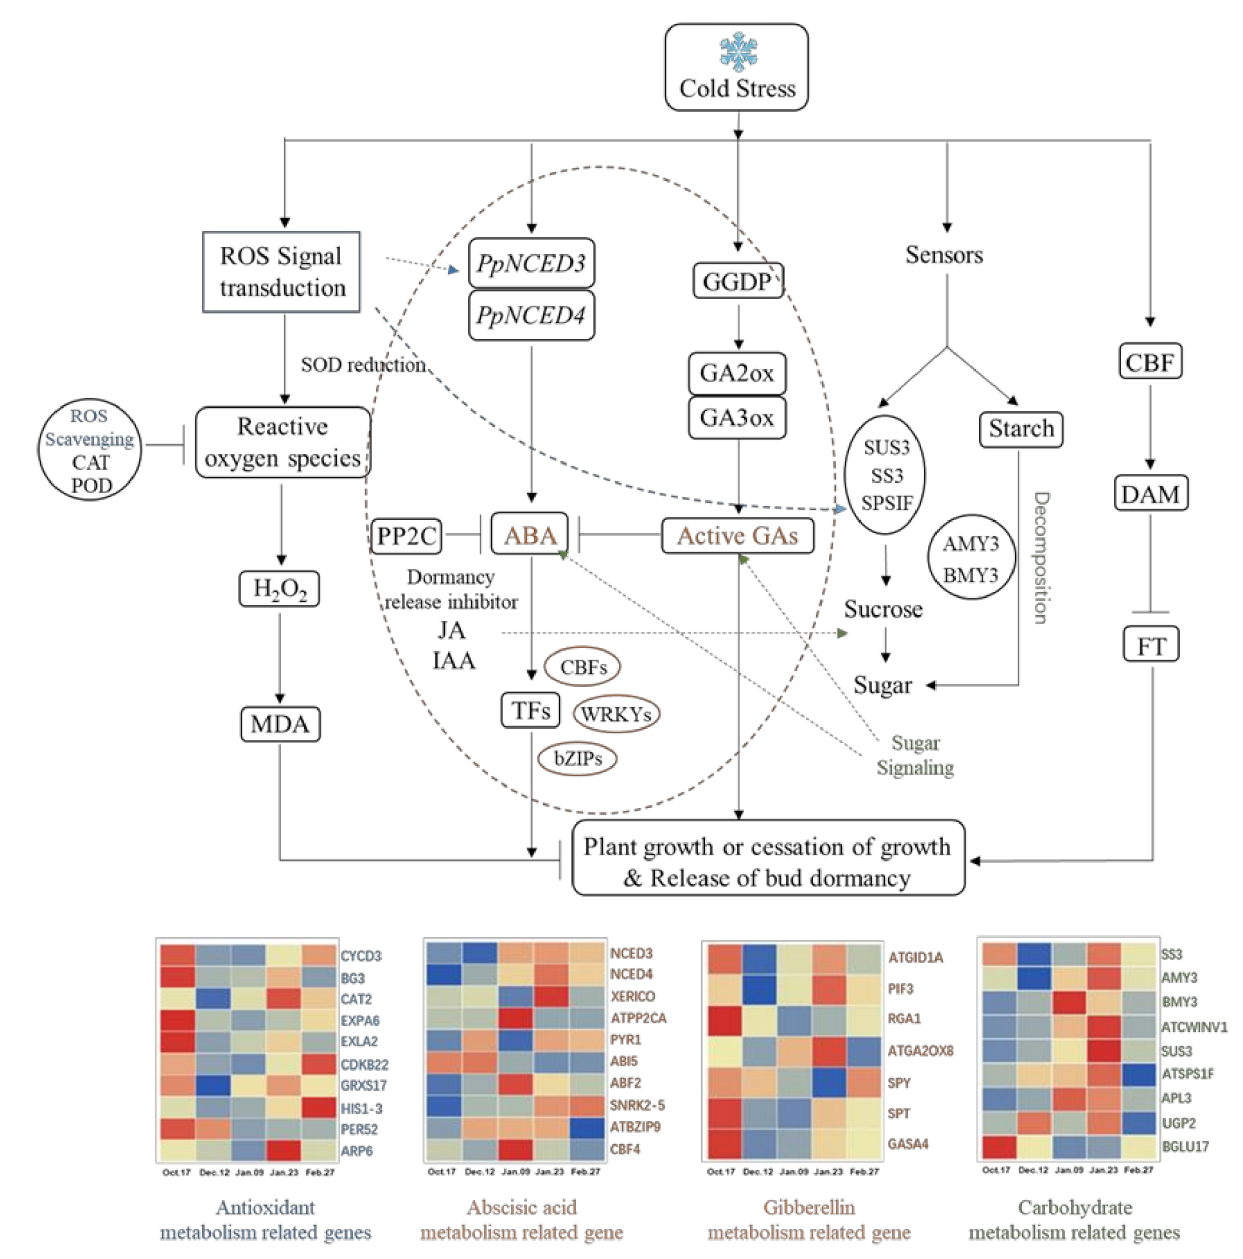
Figure 12. Underground bud endodormancy regulatory network. The picture was drawn by TBtools and Microsoft Office 2019. The data were processed by IBM SPSS Statistics 26. Full name and function of the genes are shown in Table